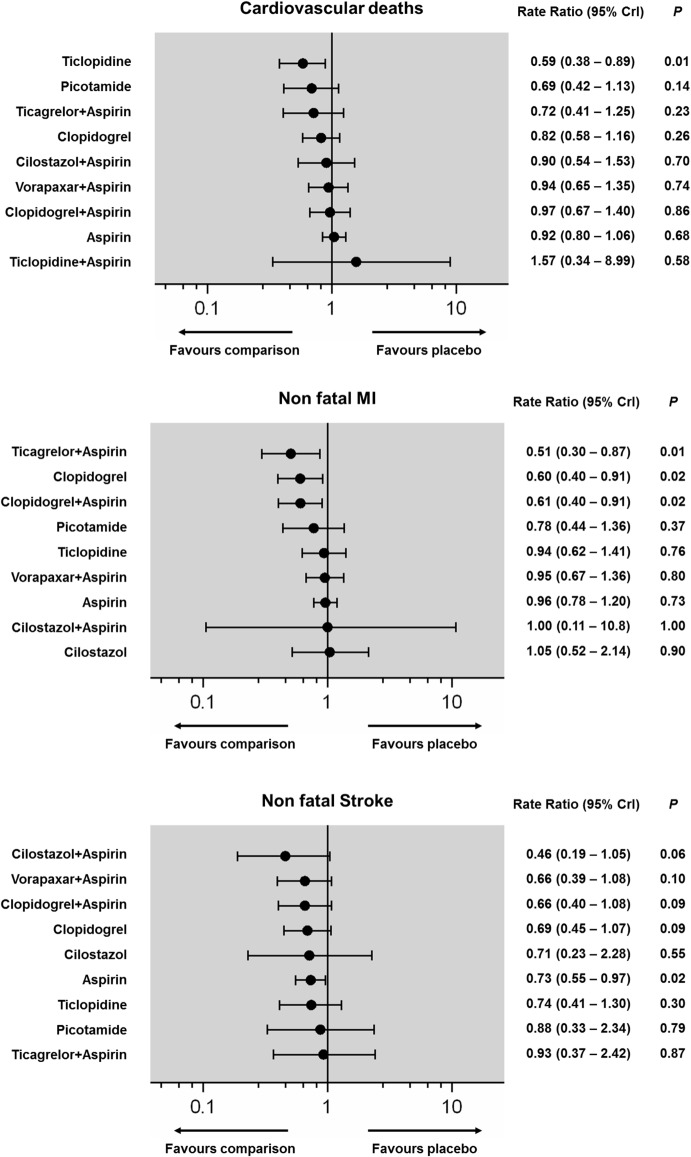
Pooled estimates for cardiovascular deaths, non-fatal MI and non-fatal stroke (Fixed effects forest plot).Antiplatelets are reported in order of efficacy ranking. Black circles denote the posterior median and the black lines denote the associated 95% CrI. Numbers represent rate ratios (RR) and 95% CrIs. P values were approximated by the two-tailed posterior probabilities.